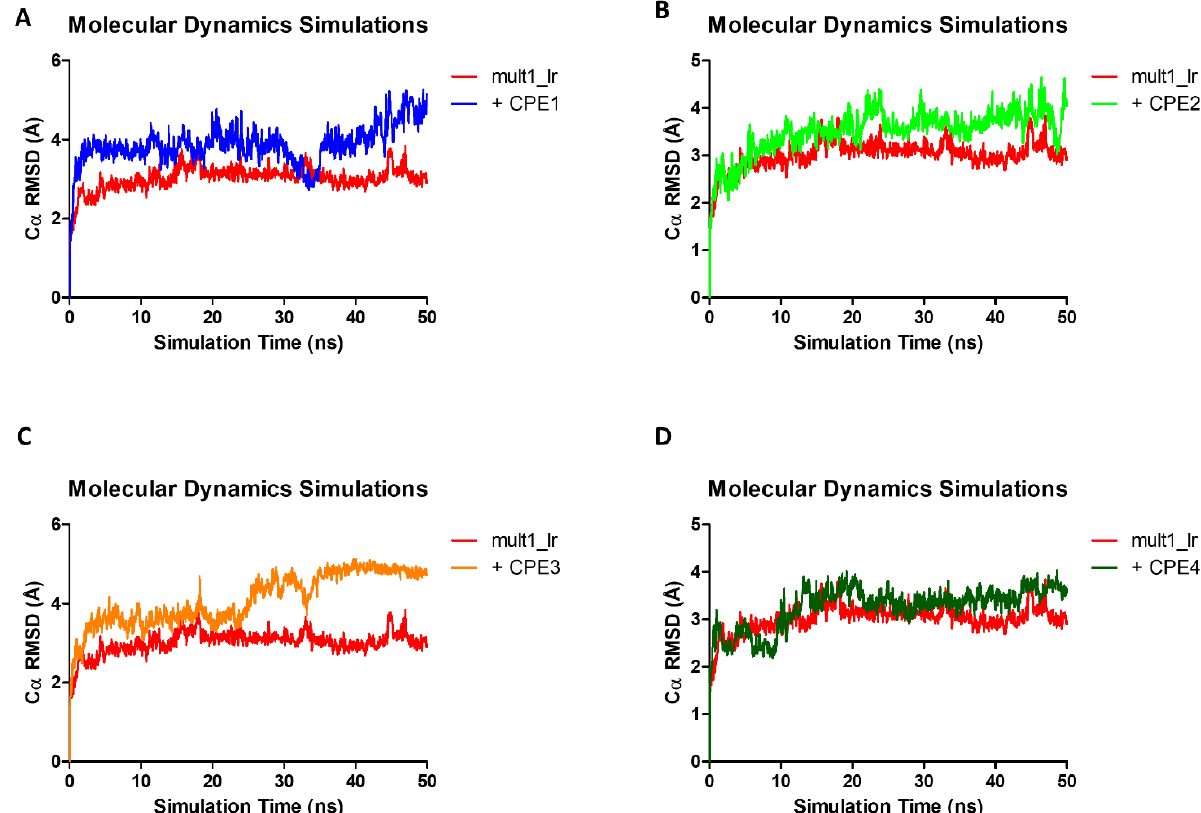
Figure 3. Molecular dynamics analysis of the stability of Mult1_lr model when isolated and when interacting with different